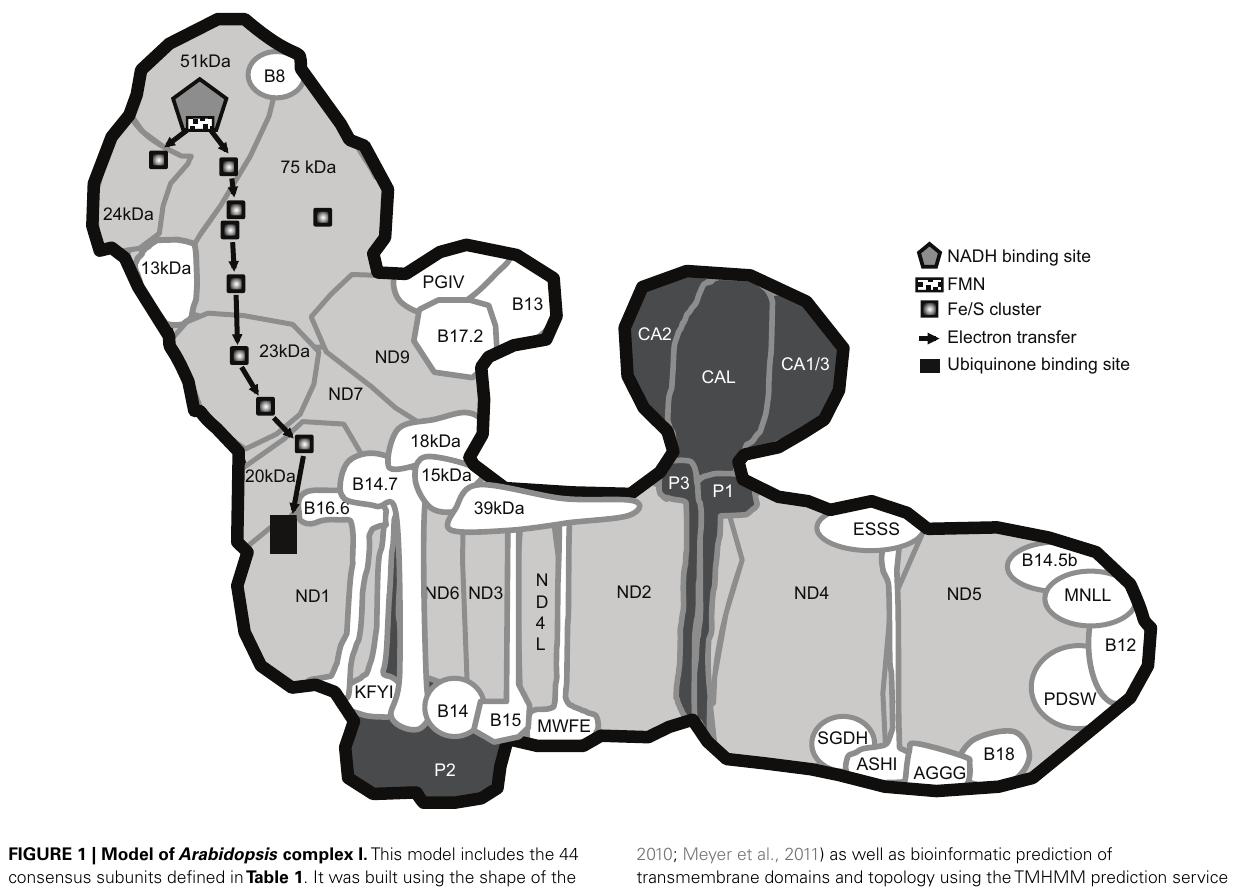
FIGURE 1 | Model of Arabidopsis complex I. This model includes the 44 consensus subunits defined in Table 1 . It was built using the shape of the complex obtained by single particle analysis (Dudkina et al., 2005), the presence of CAs in the extra matrix-facing domain (Sunderhaus et al., 2006), the structure of the bacterial enzyme for the localization of the 14 core subunits and the Fe/S clusters (Efremov and Sazanov, 2011b), the co-localization of subunits within the same subcomplex (Klodmann et al.,